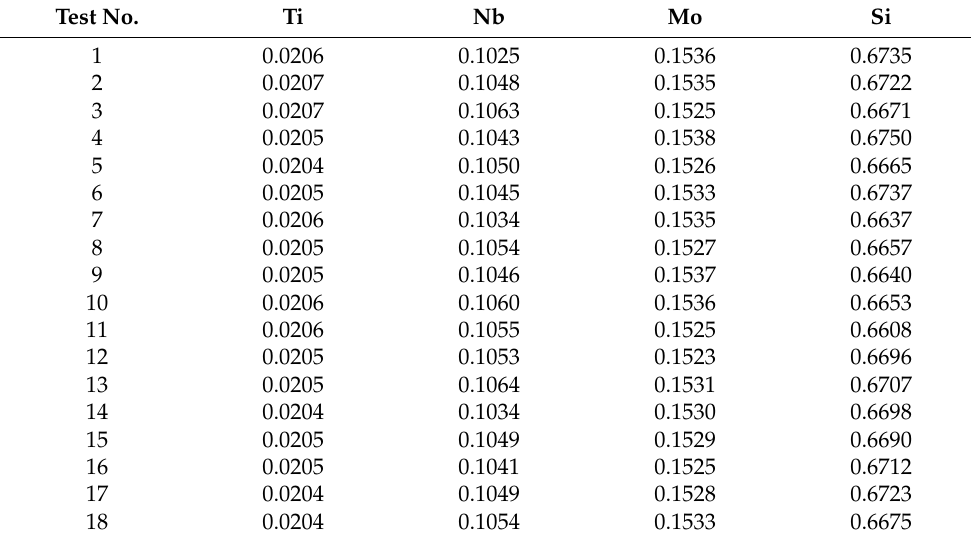
Figure 7. SEM image of the upper area after welding Table 7. Chemical properties after welding.